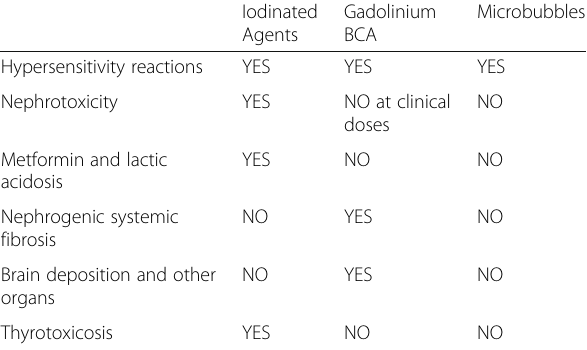
Table 1 Agent type and respective safety issues